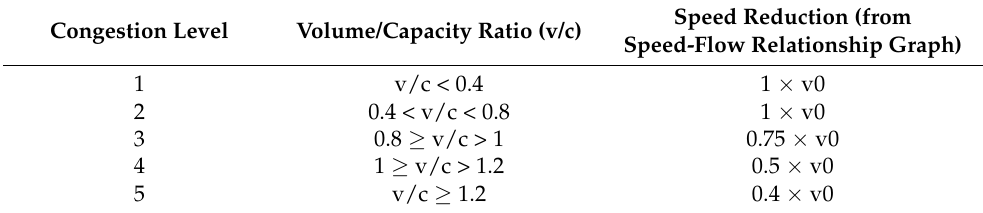
Table 6. Congestion level and speed reduction in road